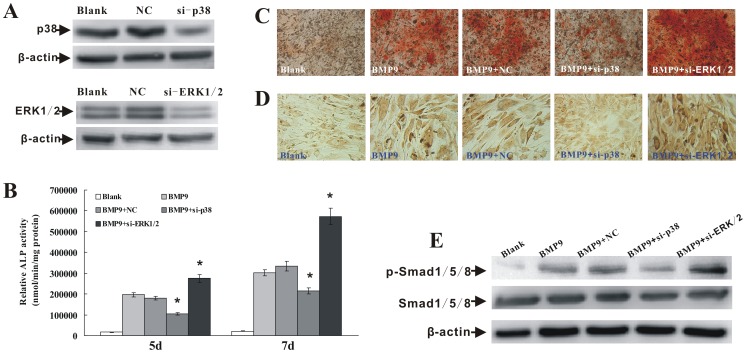
Knockdown of p38 and ERK1/2 leads to opposing effects on BMP9-indcued osteogenic differentiation of MPCs.(A) Effective knockdown of p38 and ERK1/2 expression by RNAi. C3H10T1/2 cells were infected with AdR-si-p38 or AdR-si-ERK1/2. At 24 hrs, total amount forms of p38 and ERK1/2 were analyzed by western blotting. NC, negative control. (B) Effect of p38 and ERK1/2 knockdown on BMP9-induced ALP activity. Subconfluent C3H10T1/2 cells were infected with AdR-si-p38 or AdR-si-ERK1/2, and then treated with BMP9-CM. ALP activity was quantitatively assessed at the indicated time points. “*”, p<0.05 (vs. control groups). (C) Effect of p38 and ERK1/2 knockdown on BMP9-induced matrix mineralization. C3H10T1/2 cells were Infected with AdR-si-p38 or AdR-si-ERK1/2, and then treated with BMP9-CM. At 21 days, cells were subjected to Alizarin Red S staining. Magnification, ×200. (D) Effect of p38 and ERK1/2 knockdown on BMP9-induced OC protein expression. C3H10T1/2 cells were infected with AdR-si-p38 or AdR-si-ERK1/2, and then treated with BMP9-CM. At day 12, cells were fixed and subjected to Immunocytochemical stain. Magnification, ×200. (E) Effect of p38 and ERK1/2 knockdown on BMP9-induced Smad1/5/8 phosphorylation. C3H10T1/2 cells were infected with AdR-si-p38 or AdR-si-ERK1/2, and then treated with BMP9-CM. At 30 min post BMP9-CM treatment, total amount and phosphorylated forms of Smad1/5/8 was analyzed by western blotting.